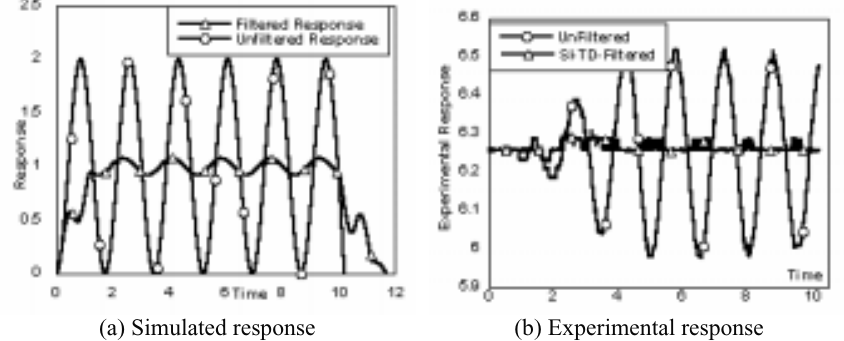
Fig. 11. (a) Simulation response to the Specified Time Delay Filtered command and the unfiltered command 10[s] length. (b) Experimental response of the mini-overhead crane without residual vibration.